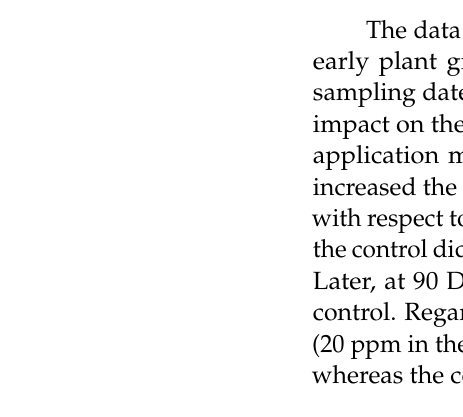
Table 4. Effect of ozone and chilling tolerance pretreatments on membrane permeability of two sweet pepper hybrids 30, 60, and 90 days after transplanting during the 2017/18 and 2018/19